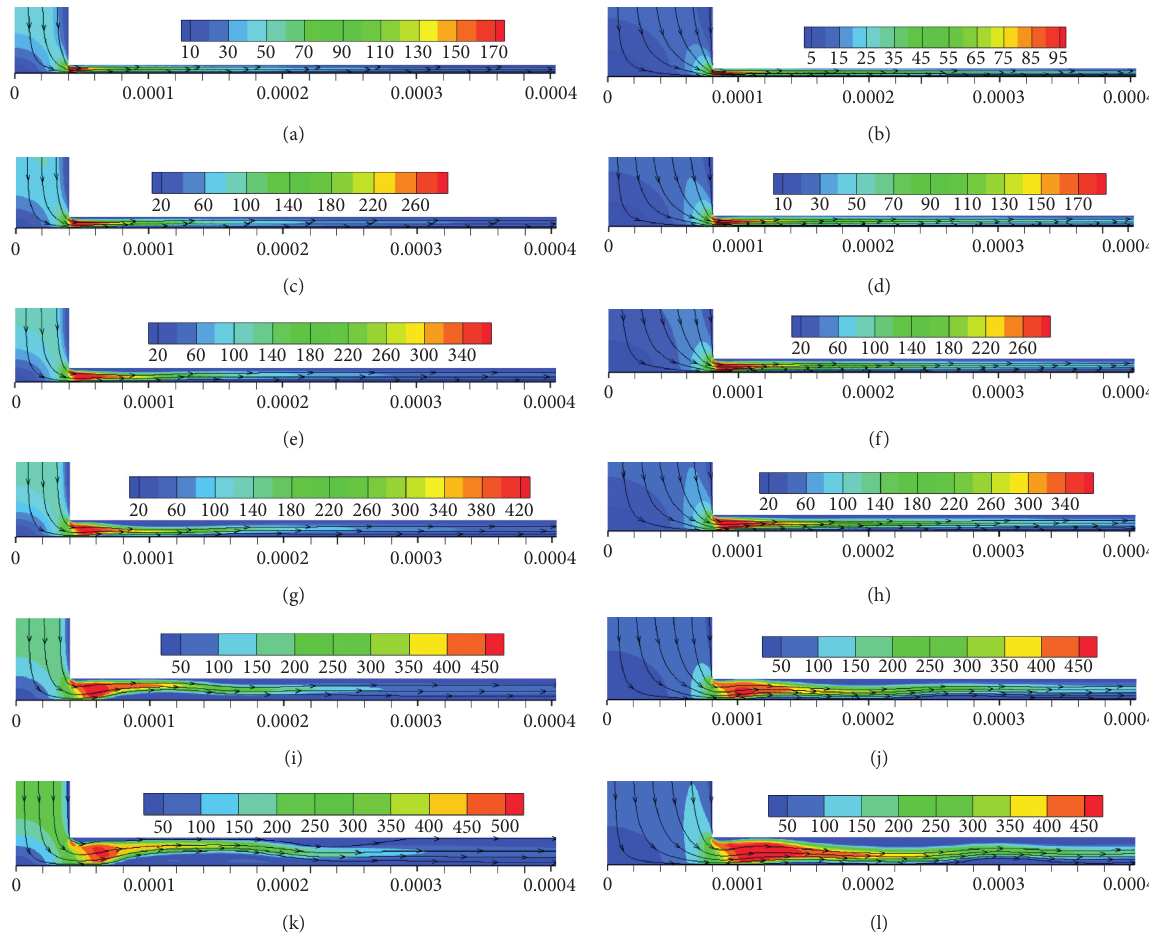
Figure 12: Cloud chart of the velocity of the gas film at different h . (a) d � 0.08mm, h � 6 μ m, (b) d � 0.16 mm, h � 6 μ m, (c) d � 0.08mm, h � 8 μ m, (d) d � 0.16mm, h � 8 μ m, (e) d � 0.08mm, h � 10 μ m, (f) d � 0.16 mm, h � 10 μ m, (g) d � 0.08mm, h � 12 μ m, (h) d � 0.16mm,